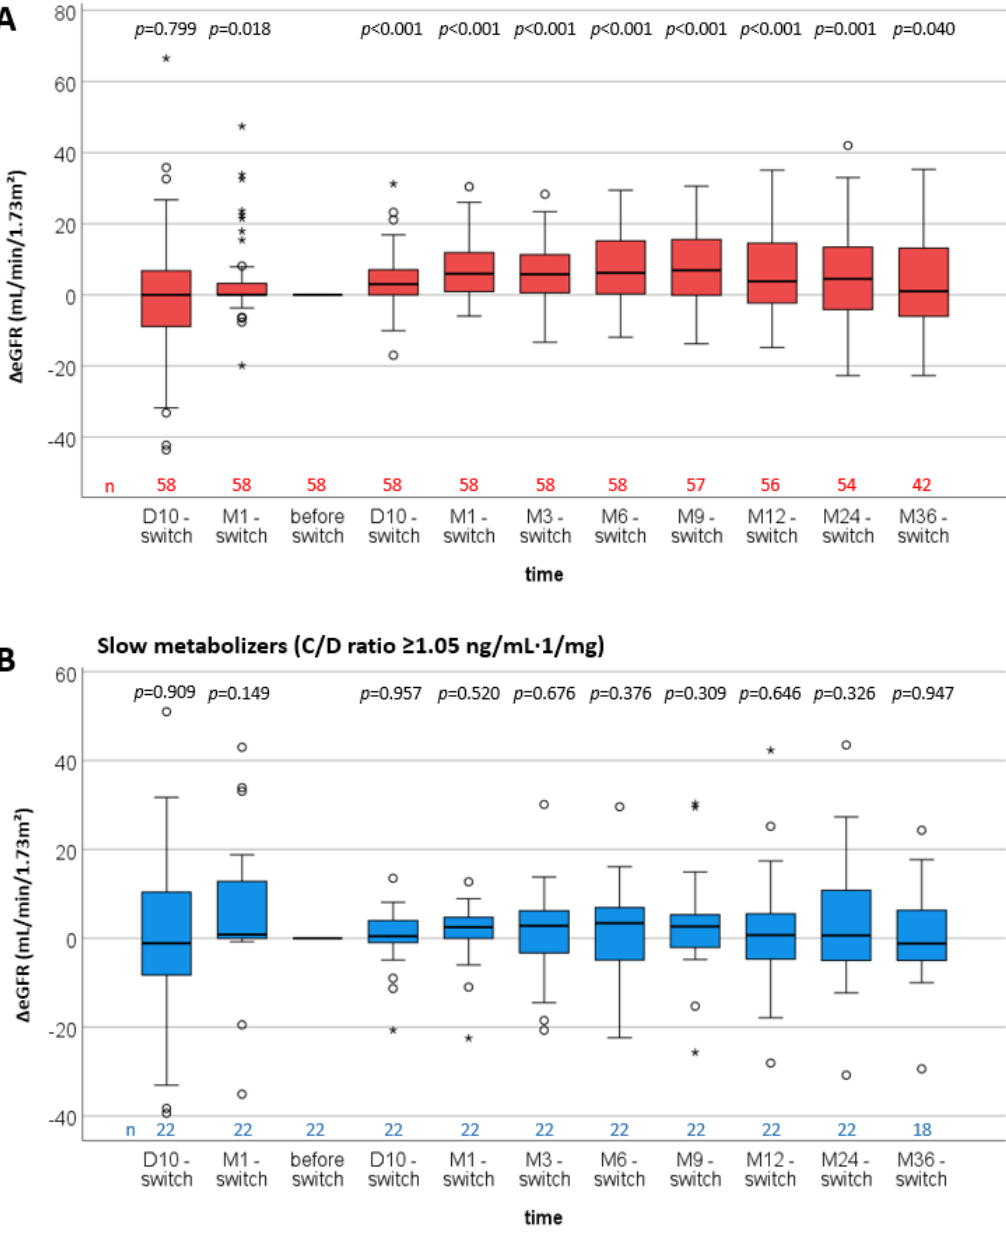
Figure 3. Boxplots of the differences in estimated glomerular filtration rates ( Δ eGFR) of fast and slow Tac metabolizers (all time points—date of the switch). p -values are from Wilcoxon-signed rank tests for the dependent comparisons of eGFR values at each time point with the eGRF values at the time of the switch. The C/D ratio cut-off to characterize the metabolizer group was 1.05 ng/mL·1/mg. Fast metabolizers developed a noticeable increase in Δ eGFR at D10 after conversion and all following time points ( A ). Δ eGFR values of slow metabolizers remained stable during the 3 years after the switch ( B ).